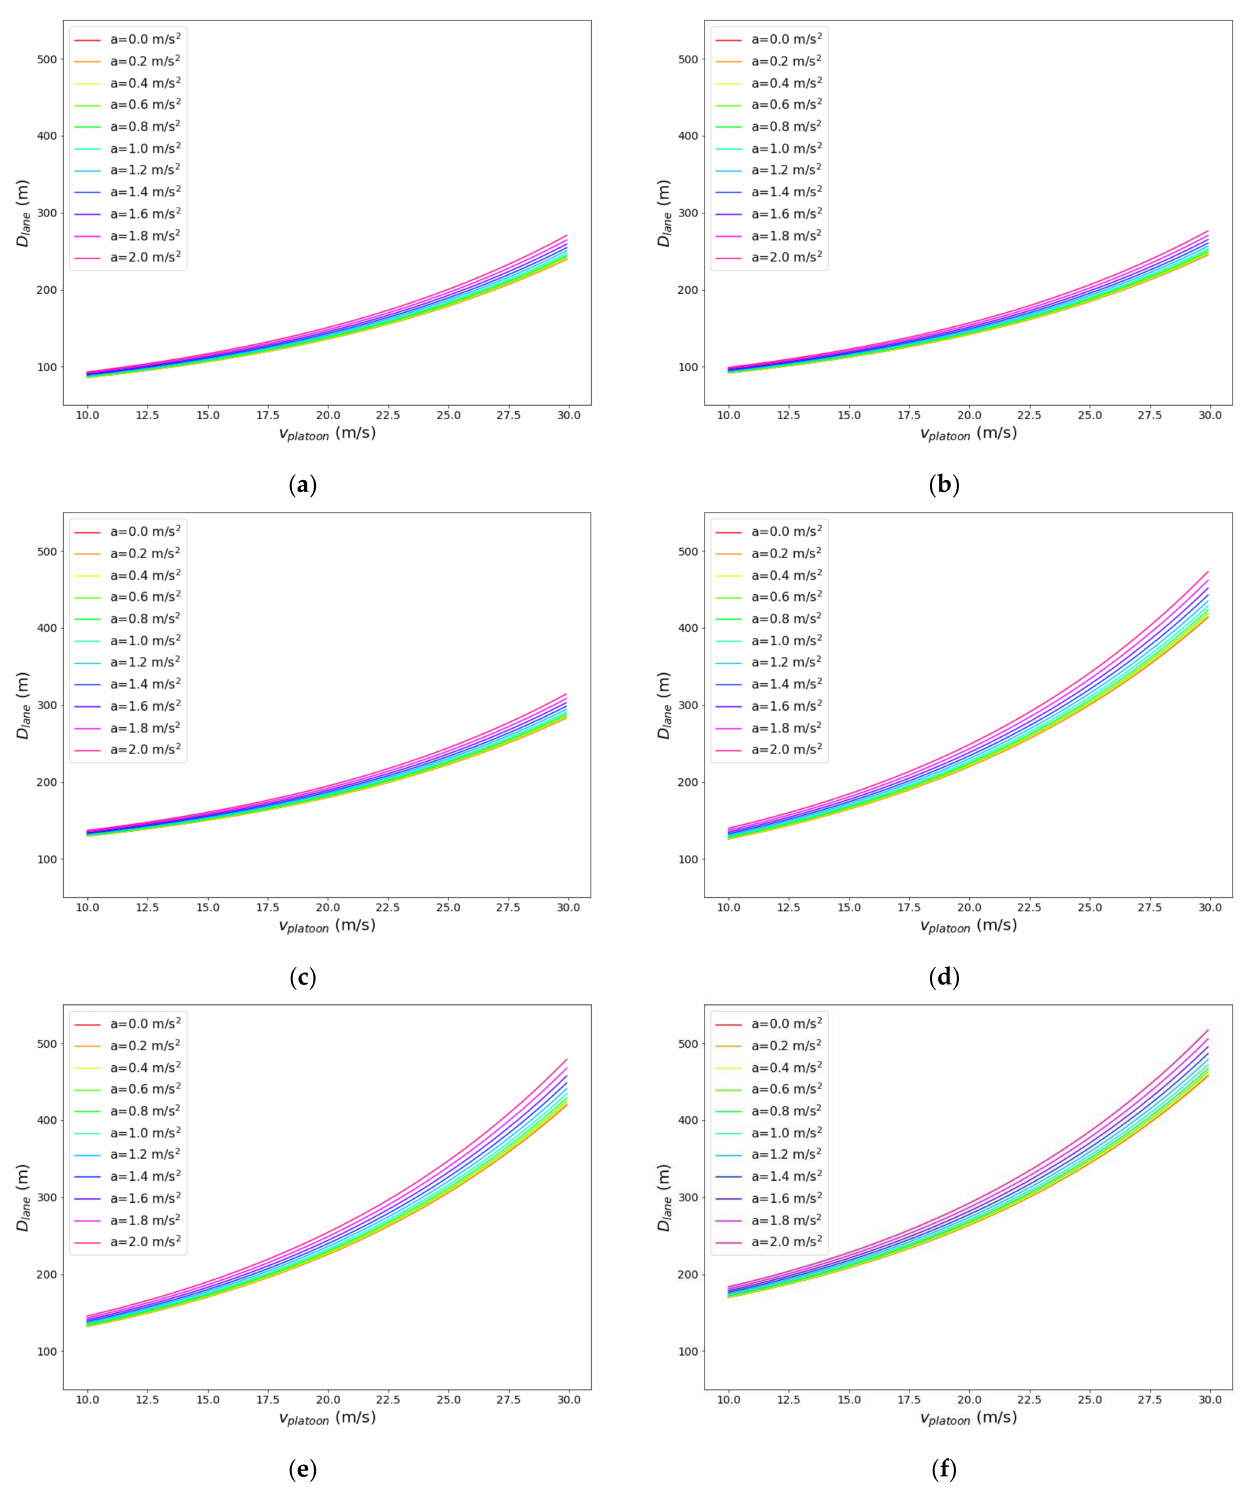
Figure 10. The curves of the dynamic gap in the platoon lane changing process under the six cases: ( a ) v f = 20 m/s, a f = 0 m/s 2 , n = 3; ( b ) v f = 20 m/s, a f = 2 m/s 2 , n = 3; ( c ) v f = 30 m/s, a f = 0 m/s 2 , n = 3; ( d ) v f = 20 m/s, a f = 0 m/s 2 , n = 6; ( e ) v f = 20 m/s, a f = 2 m/s 2 , n = 6; ( f ) v f = 30 m/s, a f = 0 m/s 2 , n =